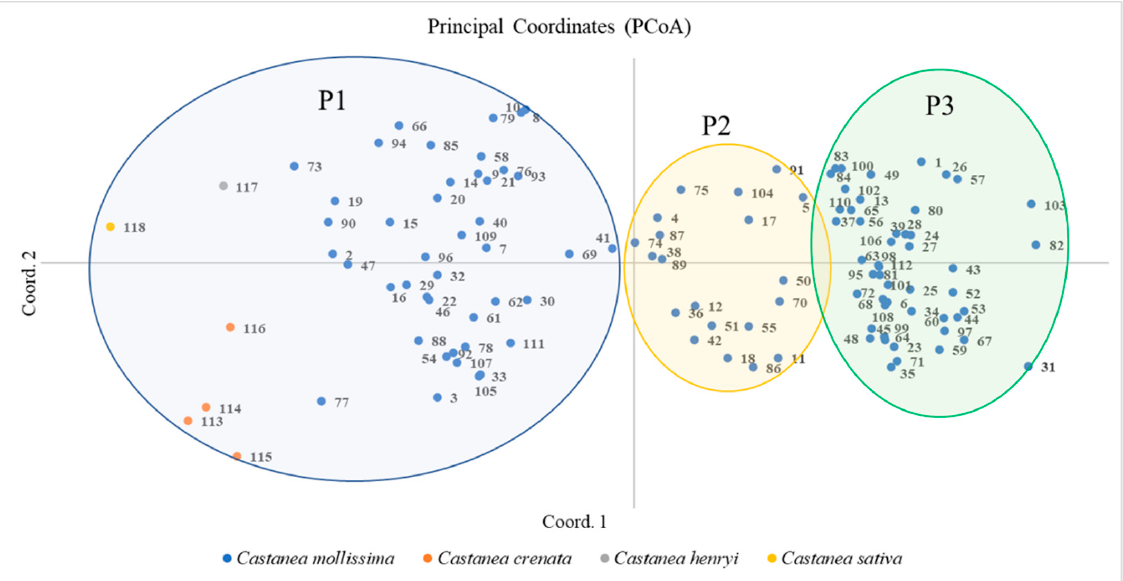
Figure 4. PCoA of 118 Castanea plant materials. The labels in the figure represent the material number (corresponding to Table S4).